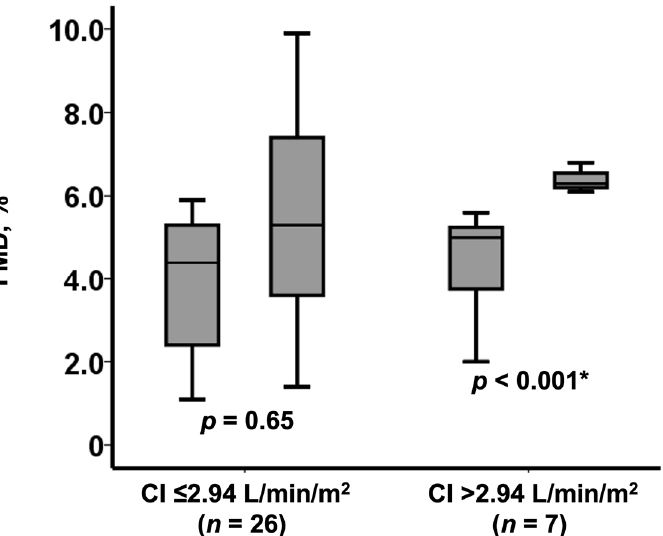
Figure 3. Change in FMD following TAVI among those with baseline low FMD ( n = 33) stratified by the baseline cardiac index level. FMD remained low in 26 patients with low cardiac index whereas increased in 7 patients with high cardiac index. CI, cardiac index. * p < 0.0.5 by Wilcoxon signed-rank test.